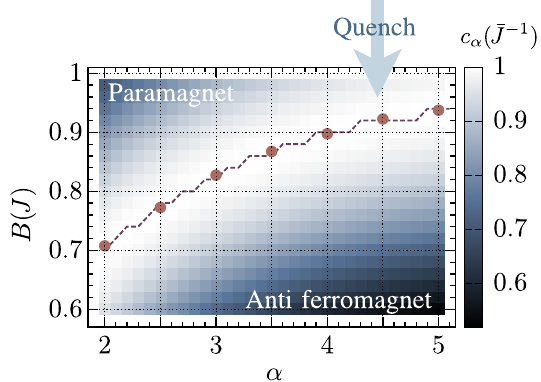
FIG. 5. The half-chain entropy growth rate c from a linear fit (cid:1) is normal- 0 < t (cid:1) J < 3 after the quench ( M ¼ 20 , ED). Each c (cid:1) ¼ ized to its maximum value in the range 0 : 6 < B < 1 , c (cid:1) ½ dS =dt (cid:7) = max ½ dS =dt ð B Þ(cid:7) . The dashed line is the contour vN vN ¼ 1 = (cid:1) J . The points show for maximum growth, i.e., c (cid:1)